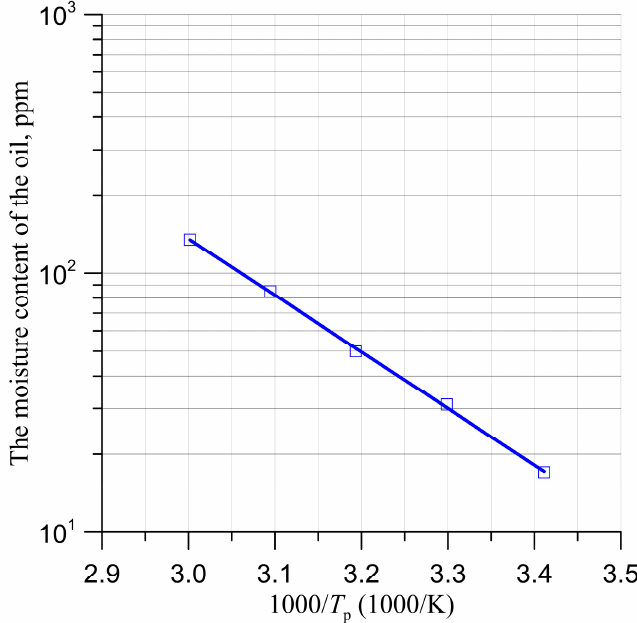
Figure 8. Arrhenius plot for the dependence of the moisture content of the oil in the state of thermodynamic equilibrium between the oil and the pressboard with a moisture content of 5.0% by weight.